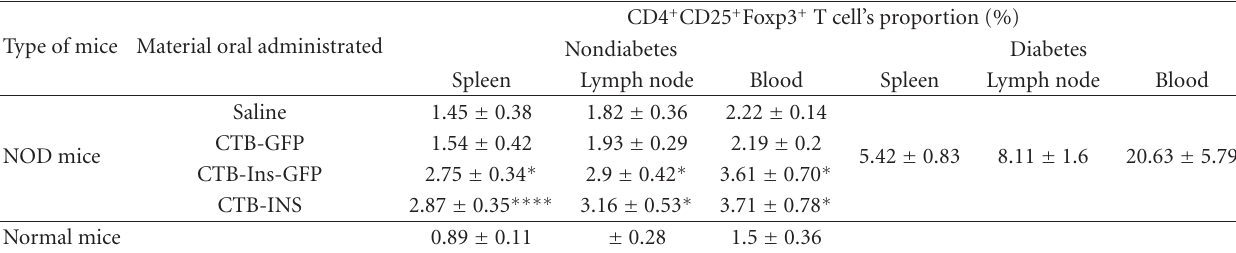
Table 2: Treg cell proportion in the peripheral lymph tissues of NOD mice.